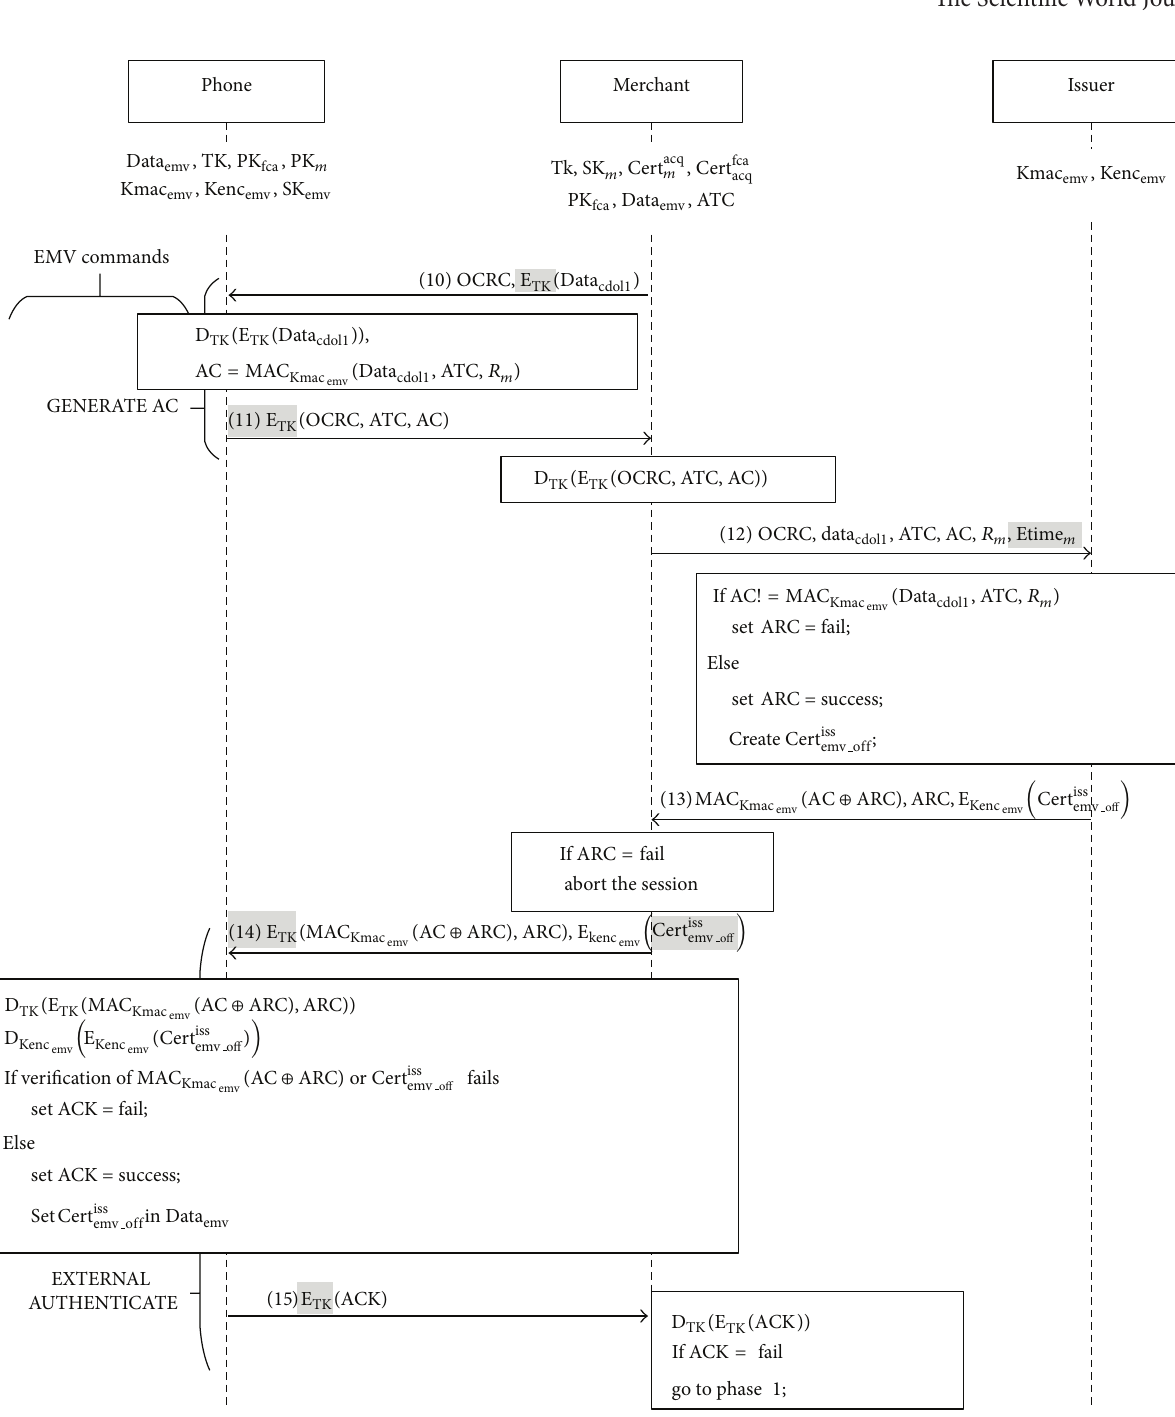
Figure 8: Deployment of offline certificate (modifications are